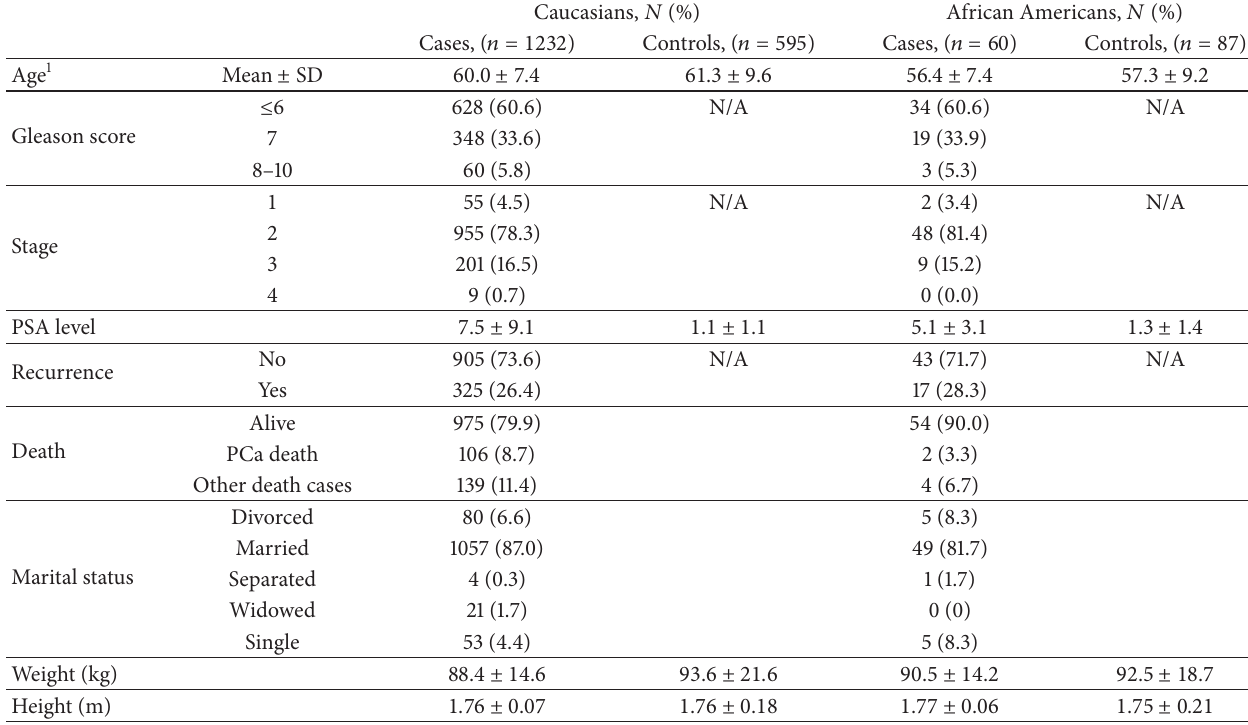
Table 1: Characteristics of study subjects by disease status and data